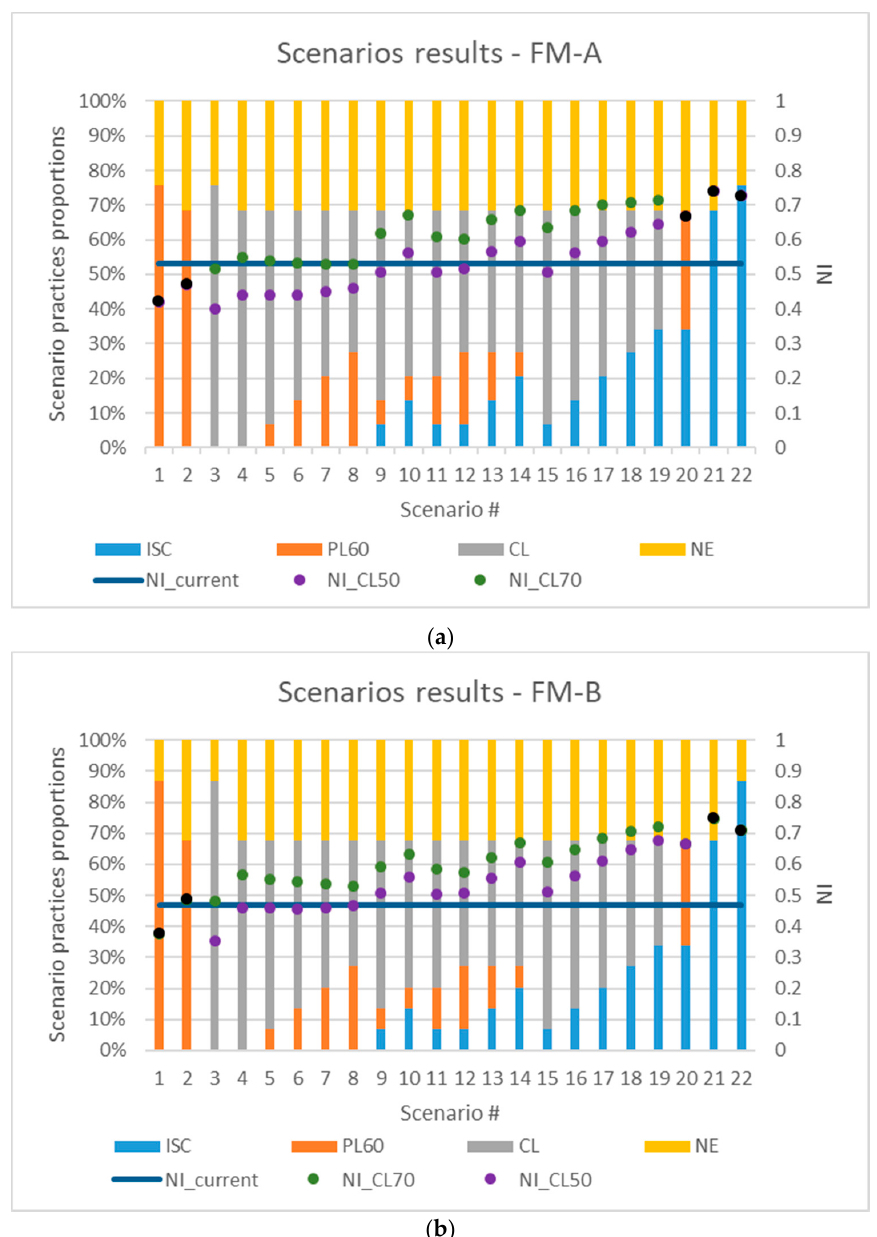
Figure 2. Naturalness assessment of forest management scenarios: ( a ) FM-A; ( b ) FM-B. For each scenario, practices mixes are illustrated using the stacked histogram: ISC: Irregular shelterwood cutting; PL60: plantation with 60 years revolution; CL: careful logging; NE: natural evolution (protection); Resulting naturalness index (NI) is indicated with the dots: NI_CL70 (green): naturalness index for CL applied in 70 years old stands; NI_CL50 (purple): naturalness index for CL applied in 50 years old stands; naturalness index for practices other than CL (black); the horizontal solid line shows the current naturalness index (2018) with the initial level of protection.